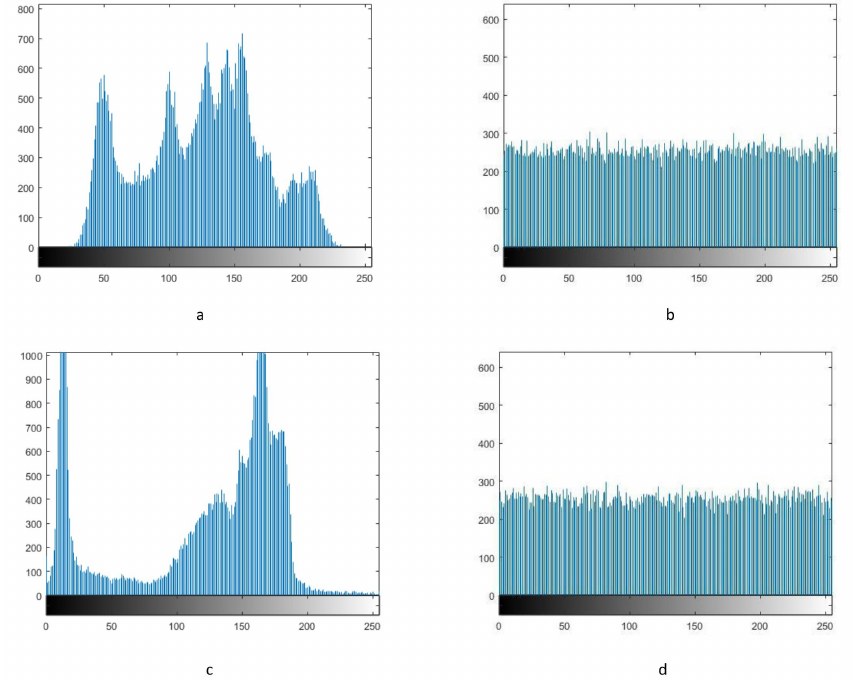
Figure 12. Histograms. ( a , b ) are histograms of Lena and its encrypted image. ( c , d ) are histograms of Cameraman and its encrypted